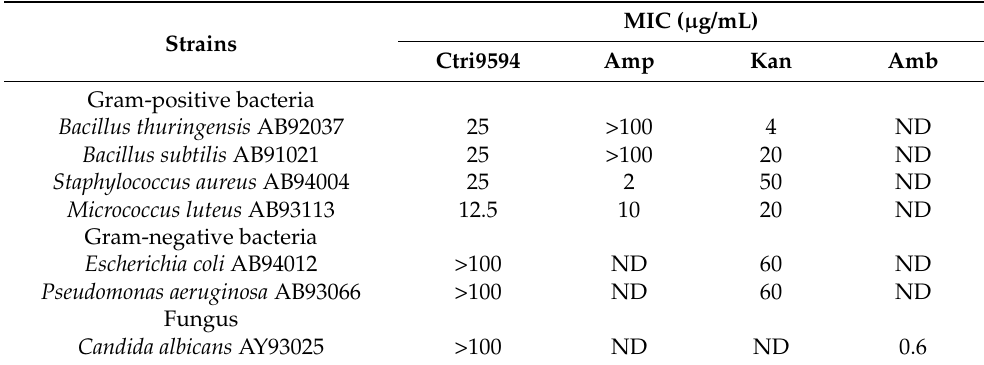
Escherichia coli AB94012